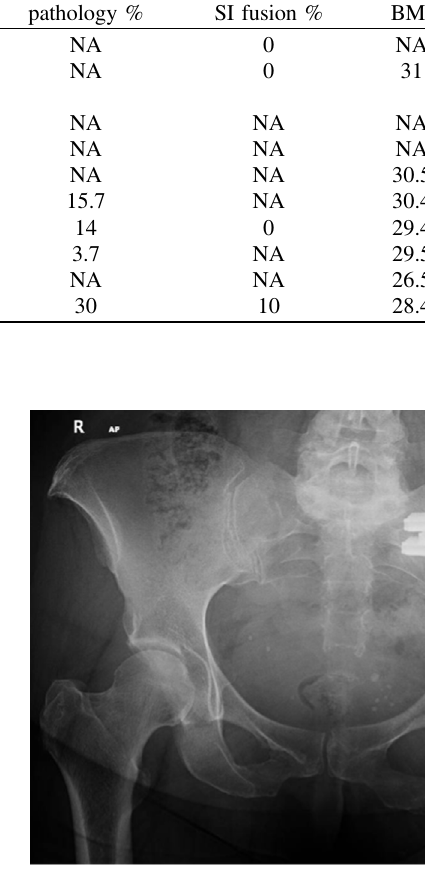
Figure 2. Ap X-ray of a pelvis, showing 1 year follow of left sacroiliac fusion, note absence of lysis or displacement, this was considered a radiological